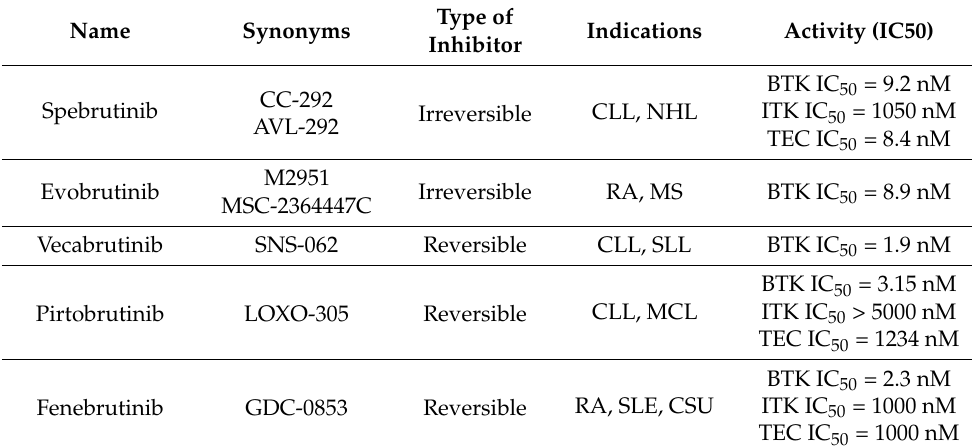
Table 2. Summary of BTKIs in clinical trials